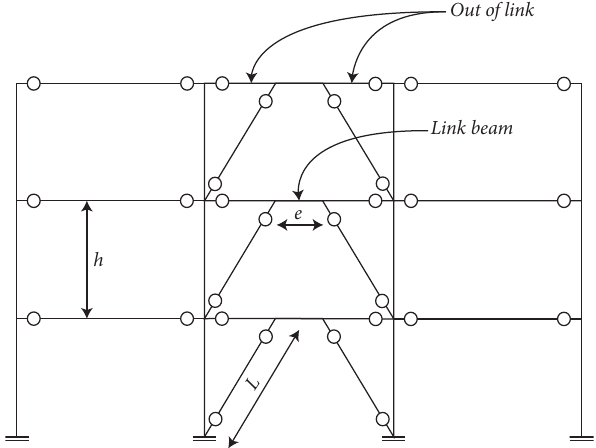
Figure 2: Typical configuration of